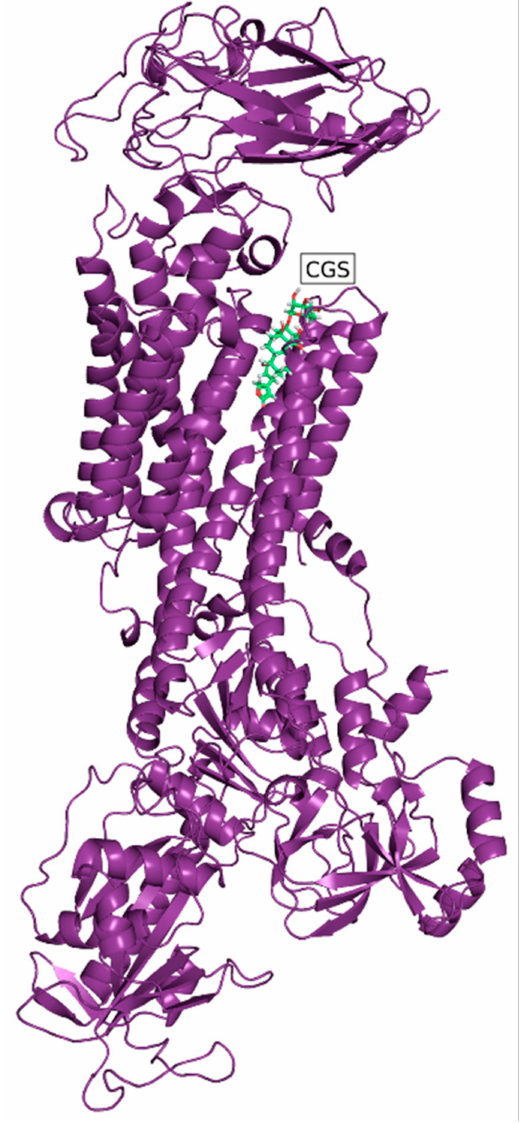
Figure 3. Far view of ouabain (green) docked into Na + /K + -ATPase (purple) with the lowest binding energy. Images were taken using PyMOL 2.3.3 (Schrödinger, LLC, New York, NY,